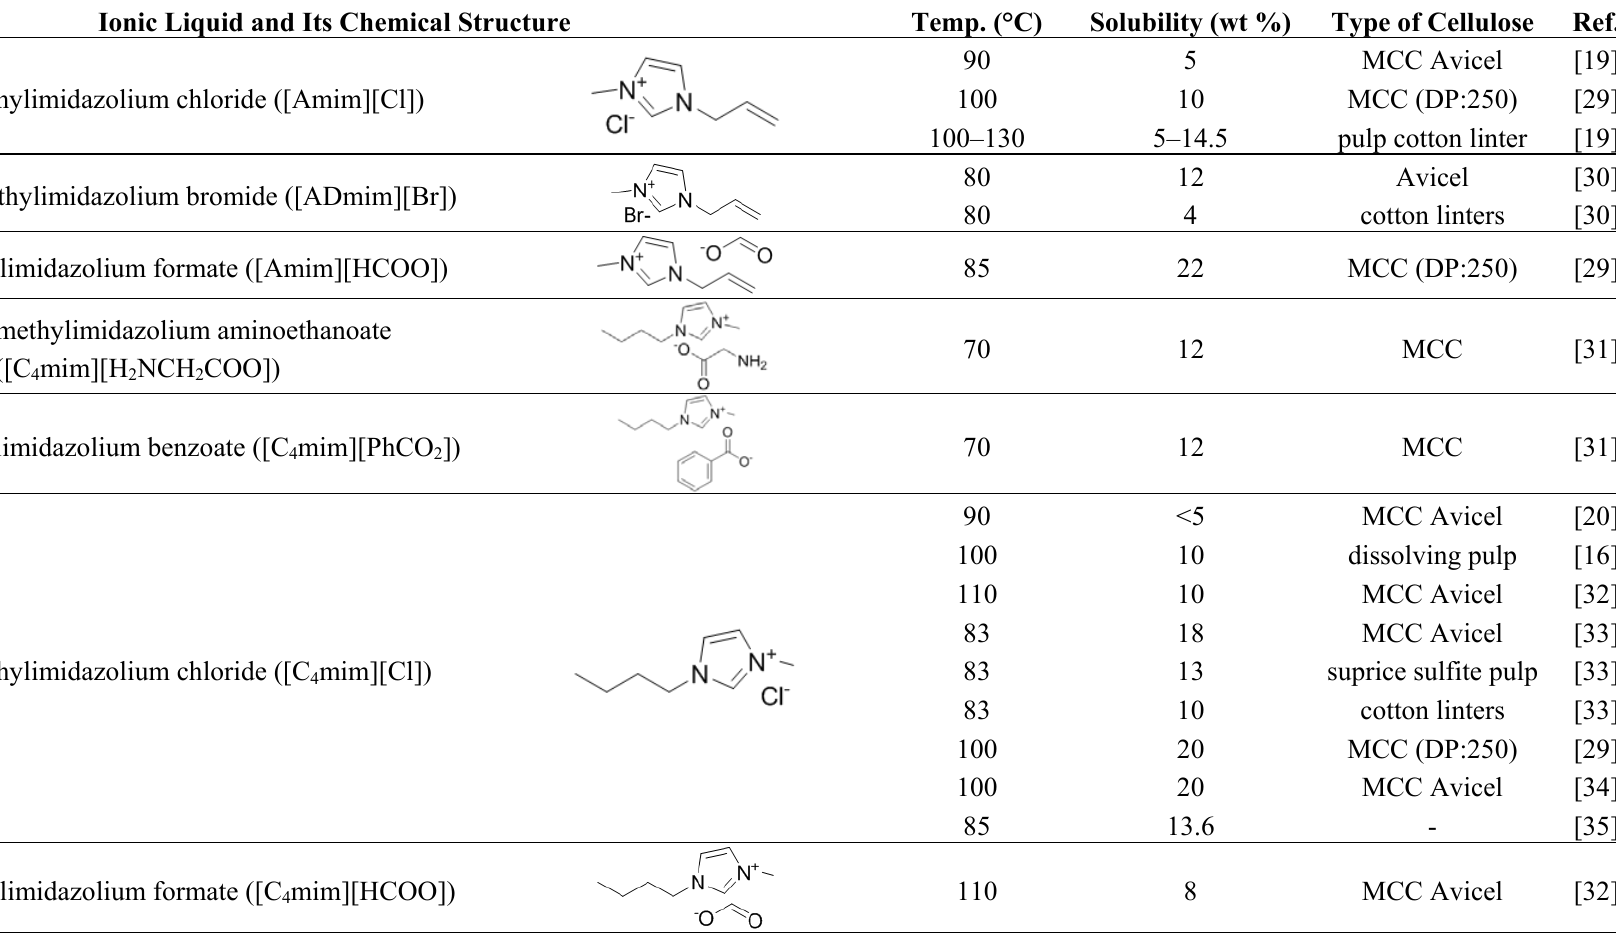
Table 1. Structures of some ionic liquids and the extent of cellulose solubility in these ionic liquids. MCC: microcrystalline cellulose, DP: degree of polymerization.